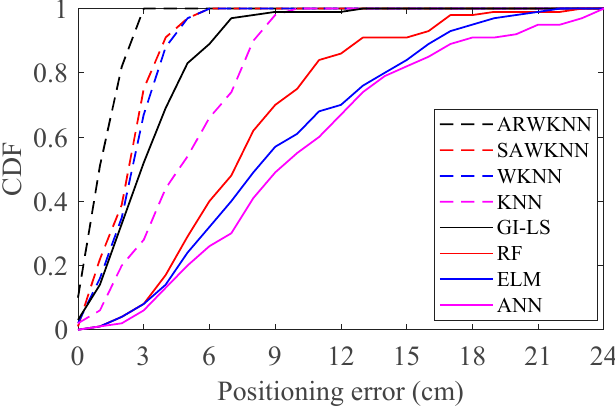
Figure 9. The cumulative distributions of positioning errors with K max = 4.